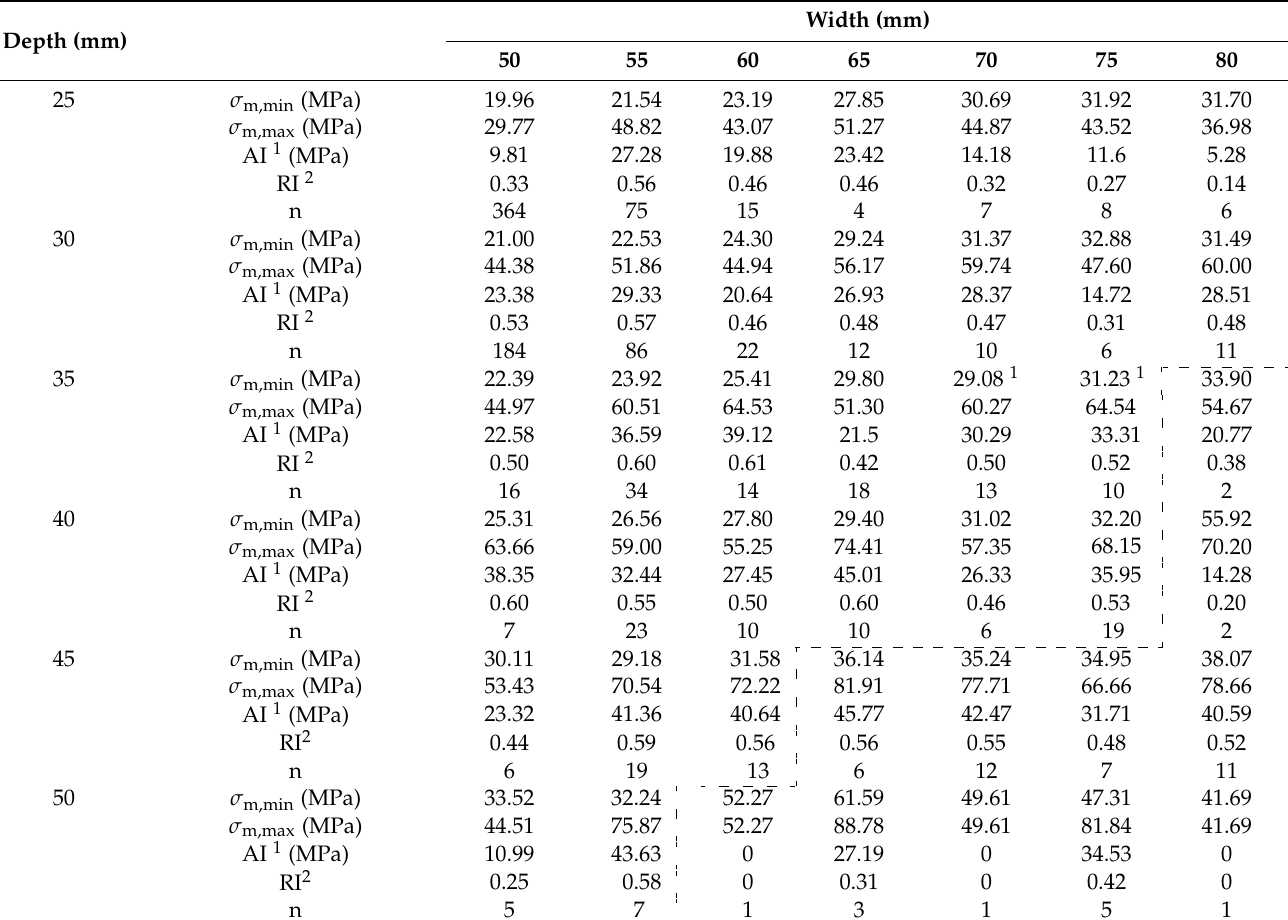
Table 2. Step 1 optimisation